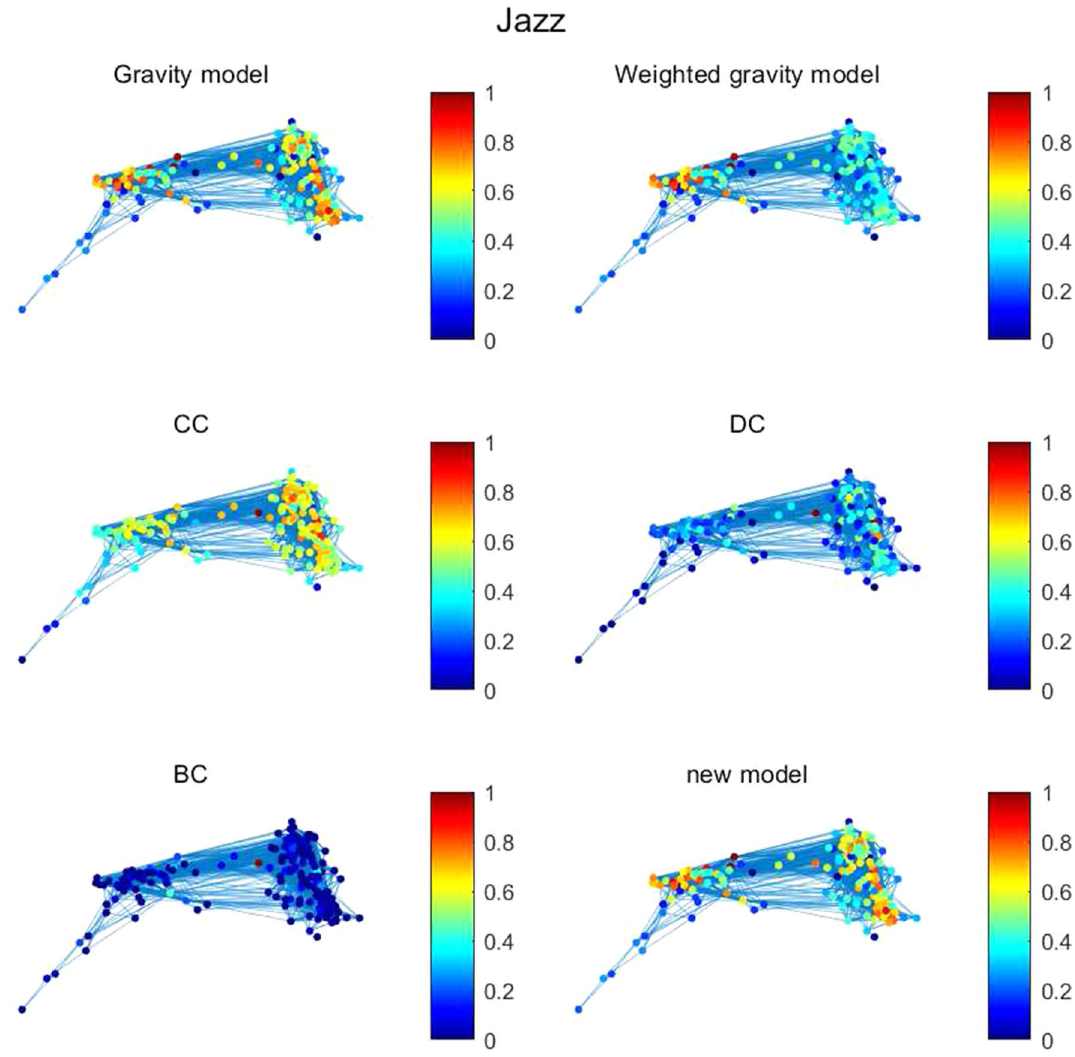
Figure 6. The figure describes node importance of six methods in Jazz. Gravity model, weighted gravity model and the new model basically perform the same. The value of nodes in BC is